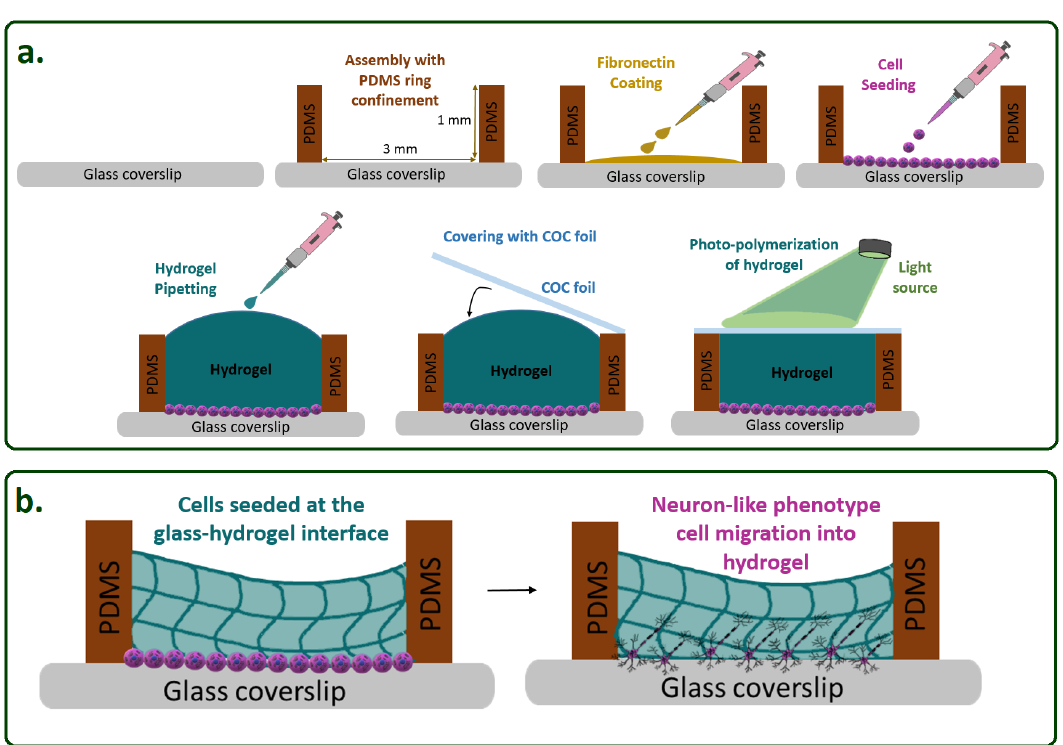
Figure 1. Schematic representation of cells seeded at a stiff-to-soft material interface. ( a ) Preparation of the 3D culture con- struct utilizing photo-polymerized hydrogels. ( b ) Before the differentiation and migration process right after cell seeding and subsequently sometime after, forming neuron-like phenotype cells and initiating neuronal processes. Polydimethylsiloxane (PDMS) and cyclic olefin copolymer